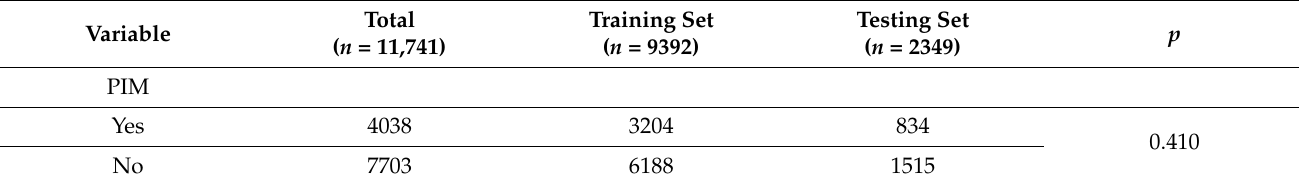
Table 1. Patient Characteristics. PIM: Potentially Inappropriate Medication.